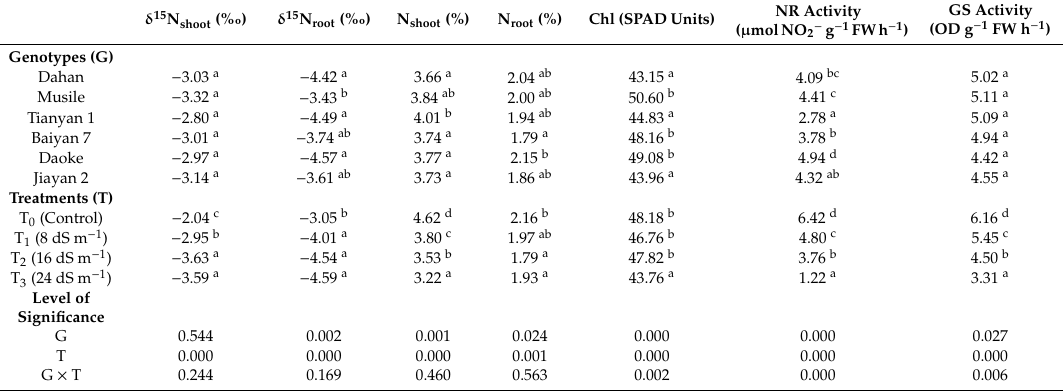
Table 4. Genotype and treatment e ff ects on nitrogen isotope composition (% (cid:24) ) of shoots ( δ 15 N shoot ) and roots ( δ 15 N root ), nitrogen concentration of shoots (N shoot ) and roots (N root ), glutamine synthetase activity (GS activity), nitrate reductase activity (NR) and leaf chlorophyll content (Chl) of six oat genotypes in various salinity conditions. Genotype values are the means of 12 measurements (four treatments and three replicates per treatment), while treatment values are the means of the 18 measurements (six genotypes and three replicates per genotype). Means followed by di ff erent letters are significantly di ff erent ( p < 0.05) according to Tukey’s-b